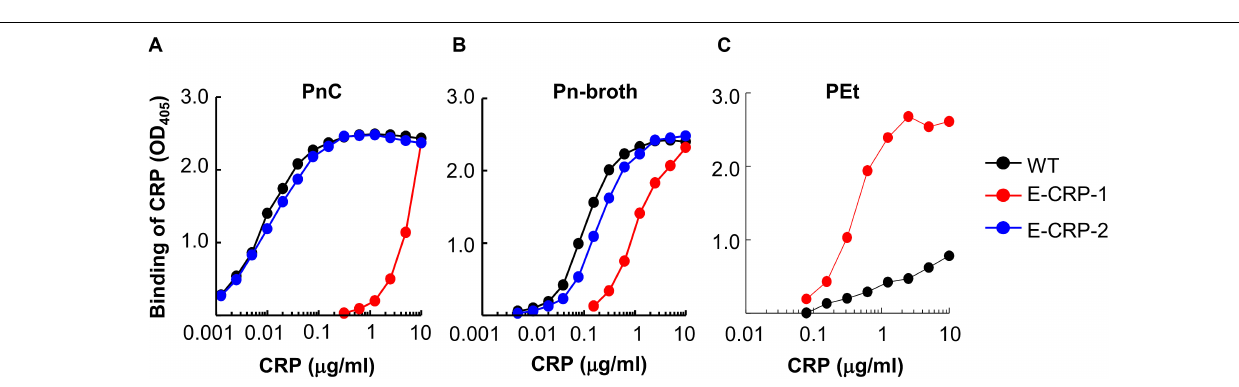
FIGURE 2 | Binding of CRP to PCh. (A) Binding of WT CRP, E-CRP-1 and E-CRP-2 to PnC immobilized on microtiter wells. (B) Binding of WT CRP, E-CRP-1 and E-CRP-2 to broth-cultured pneumococci (Pn-broth) immobilized on microtiter wells. (C) Binding of WT CRP and E-CRP-1 to a PEt-ligand immobilized on microtiter wells. A representative of three experiments is shown for each